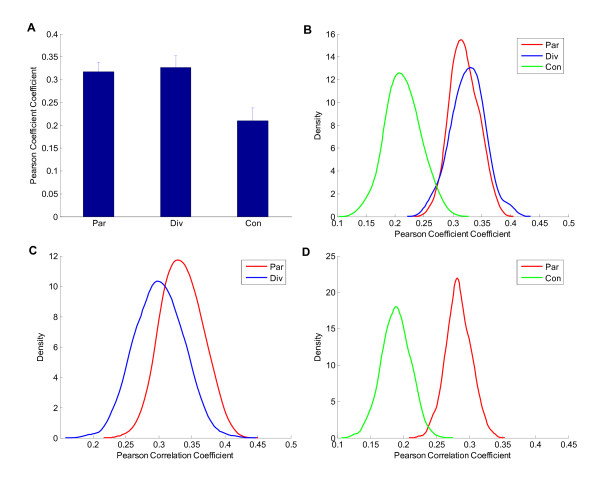
Comparing the correlation of ΔH3K14ac between immediate neighboring genes of different directions. The correlation was calculated by a bootstrap analysis (repeated 1000 times) across all neighboring parallel (→ →), divergent (← →) and convergent (→ ←) pairs. The ΔH3K14ac level of a gene was defined as the mean level of ΔH3K14ac in its translated region. (A) Mean correlation of gene pairs with different transcriptional directions (Par, parallel pairs; Div, divergent pairs; Con, convergent pairs). The error bar is the standard deviation. (B) Distribution of correlation for divergent (red), parallel (blue) and convergent (green) gene pairs. (C) Distribution of correlation for parallel (red) and divergent (blue) pairs whose ORF 5' distance was 600~1200 bp. (D) Distribution of correlation of parallel (red) and convergent (green) pairs whose ORF 5' distance was 1600~3600 bp.